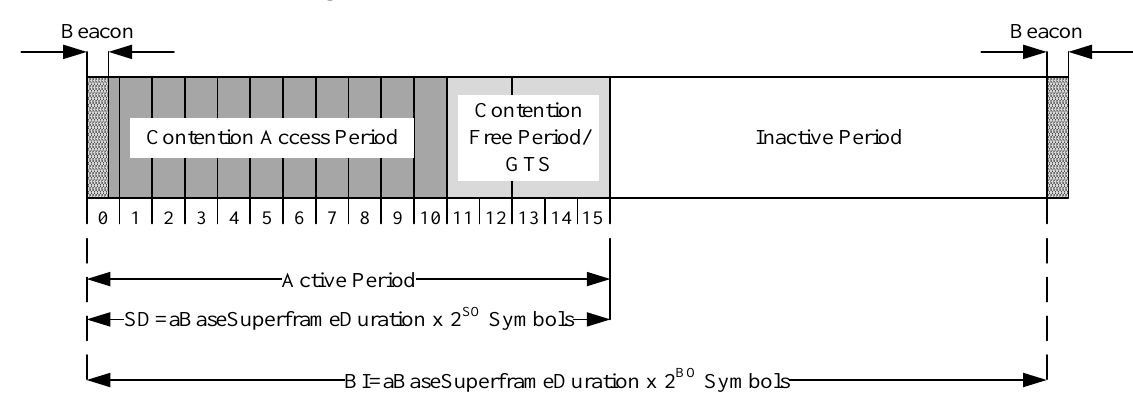
Figure 2. IEEE 802.15.4 superframe